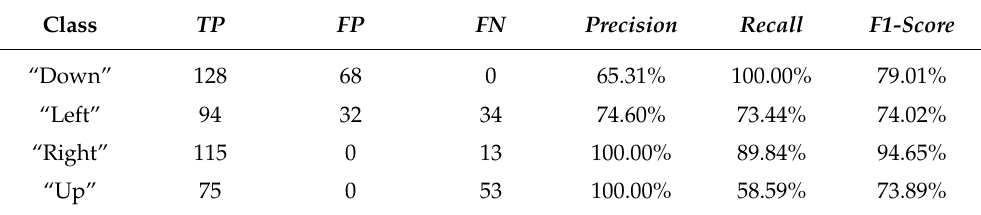
Table 4. Performance metrics of the network trained and validated with data in Figure 6a.